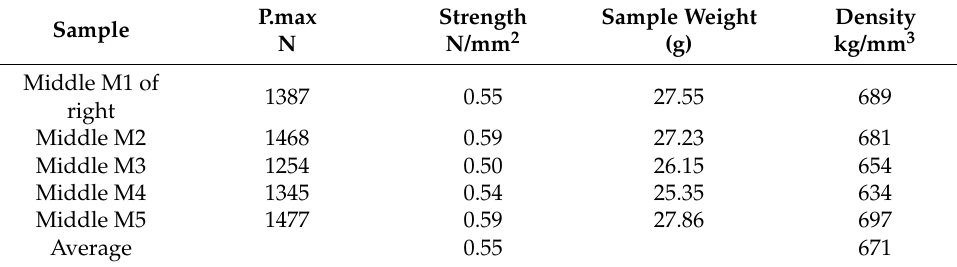
Table 14. Internal bonding test results.